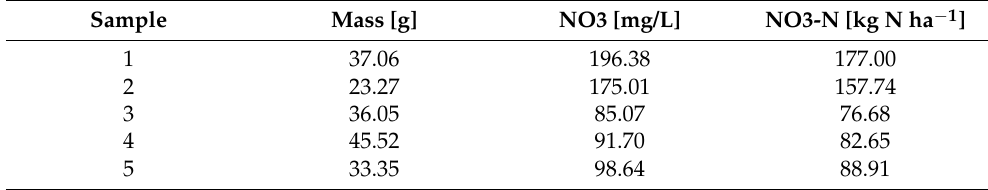
Table 2. The measurement results from the test performed on the plot within the field of the commercial farm in the locality Krivaja, Serbia.